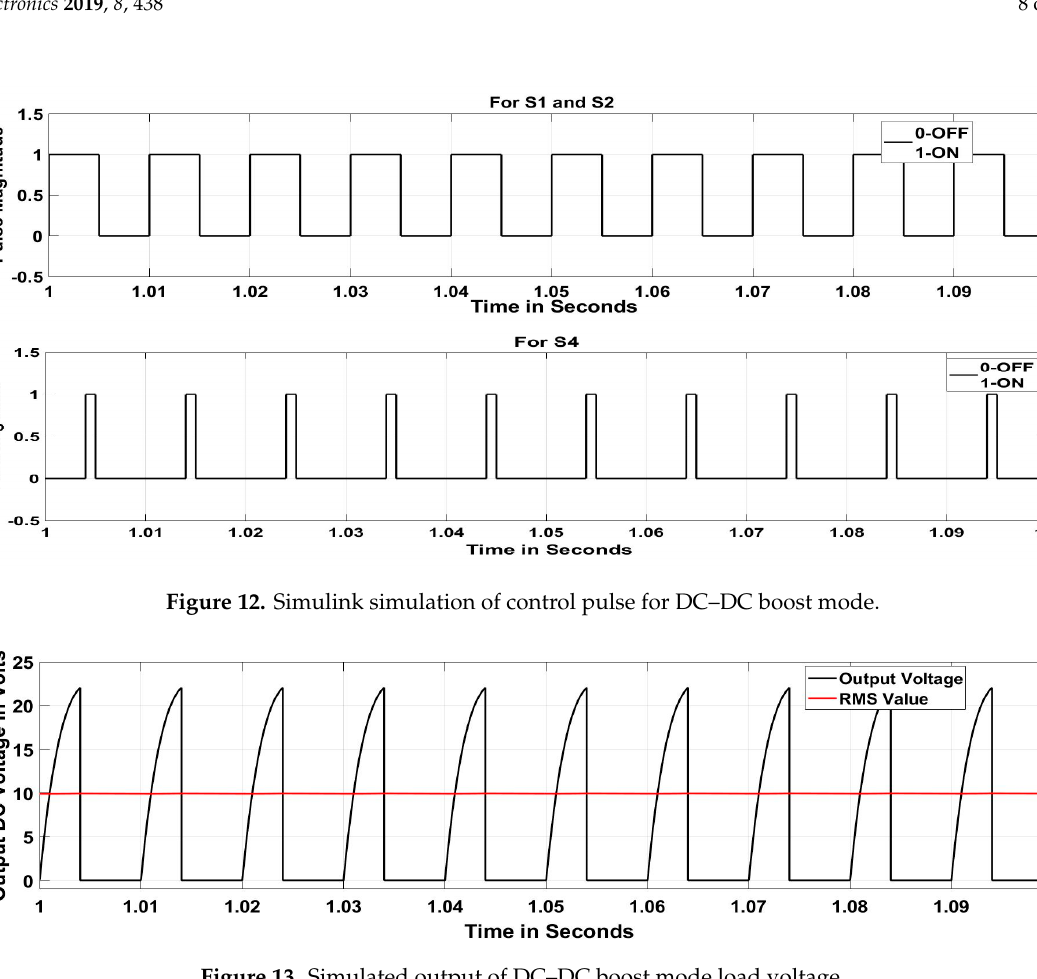
Figure 13. Simulated output of DC–DC boost mode load voltage.